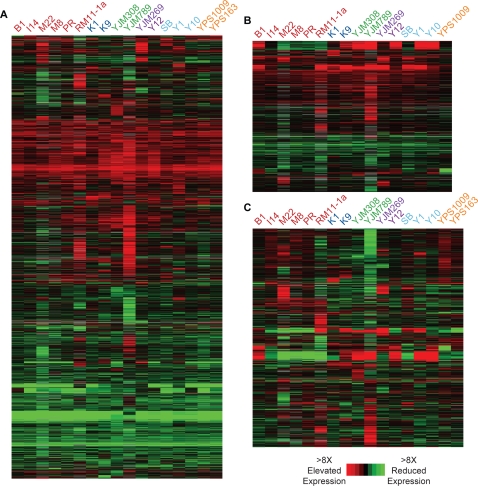
Variation in gene expression in S. cerevisiae
isolates.The diagrams show the average log2 expression differences measured in the
denoted strains. Each row represents a given gene and each column
represents a different strain, color-coded as described in Figure 1. (A)
Expression patterns of 2,680 genes that varied significantly
(FDR = 0.01, paired t-test) in at least
one strain compared to S288c. (B) Expression patterns of 953 genes that
varied significantly in at least one strain compared to strain YPS163
(FDR = 0.01, unpaired t-test). For (A)
and (B), a red color indicates higher expression and a green color
represents lower expression in the denoted strain compared to S288c,
according to the key. (C) Expression patterns of 1,330 genes that varied
significantly (FDR = 0.01, paired
t-test) in at least one strain compared to the mean expression of all 17
strains. Here, red and green correspond to higher and lower expression,
respectively, compared to the mean expression of that gene in all
strains. Genes were organized independently in each plot by hierarchical
clustering.